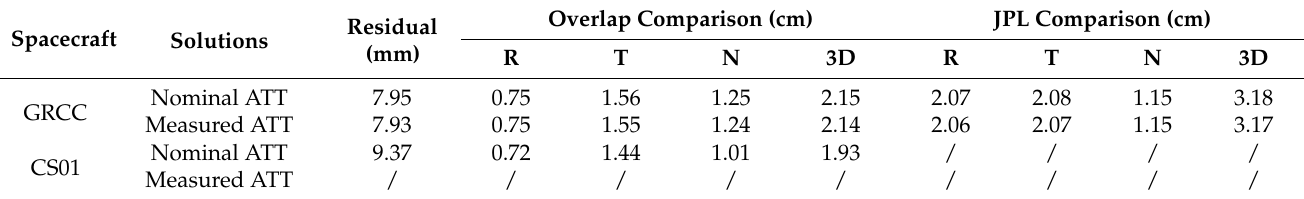
Figure 5. RMS of orbital differences for GRCC and CS01 using nominal and measured attitude model. Table 2. The RMS of residual and orbital comparison using nominal and measured attitude for GRCC and CS01.